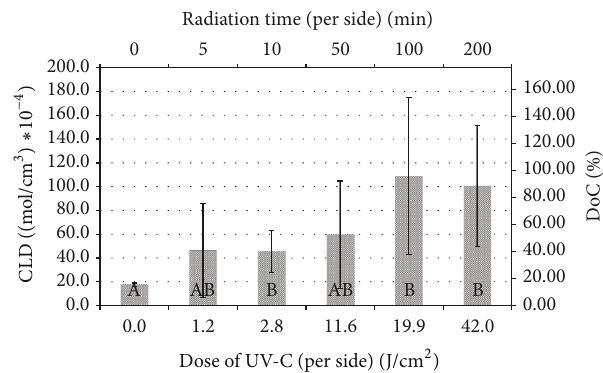
Figure 1: Influence of UV radiation dose and respective radiation time on DoC and CLD of WPI-based cast films. Bars with different letters are significantly different (𝑝 < 0.05)